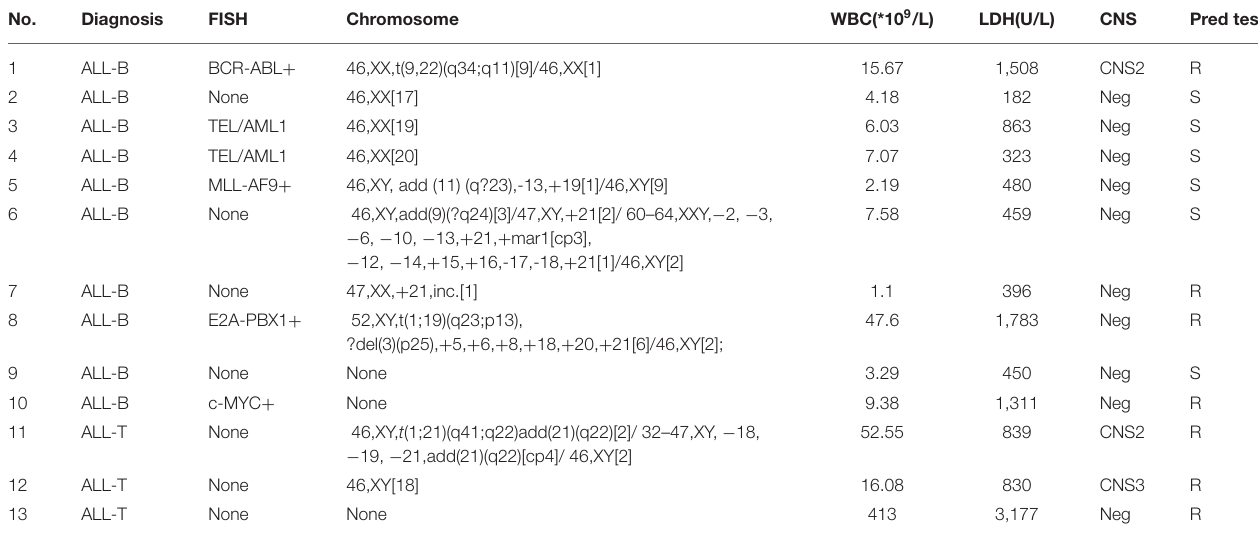
TABLE 2 | Clinical information from patients with TTN + mutations.